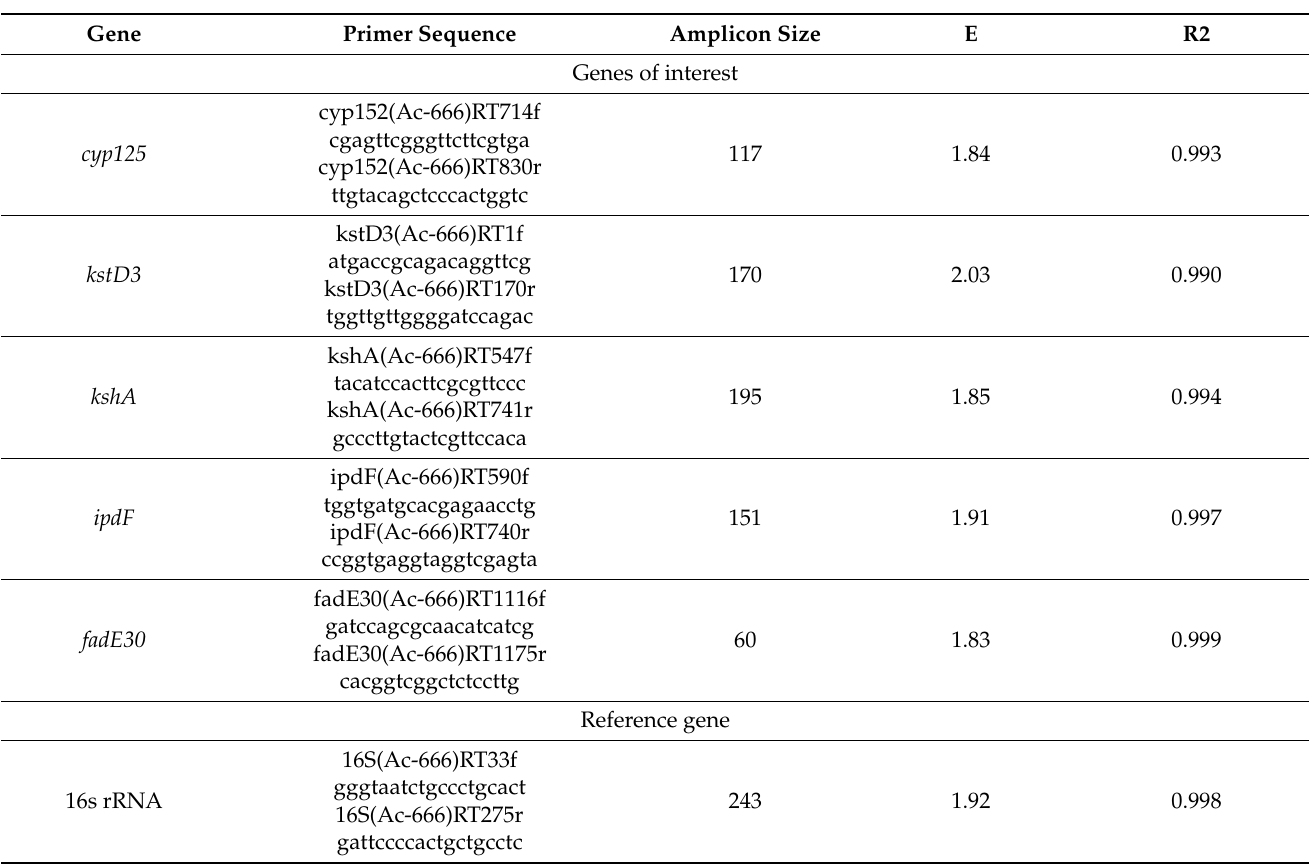
Table 3. Genes of S. hirsuta whose expression was increased in response to induction with cholesterol for 24